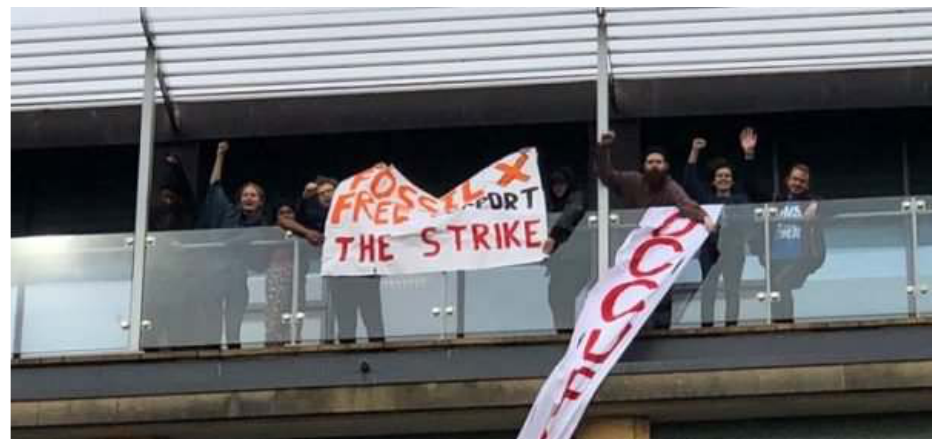
Figure 4. Bristol University ‘Student Staff Solidarity Group’ occupy the Senate room